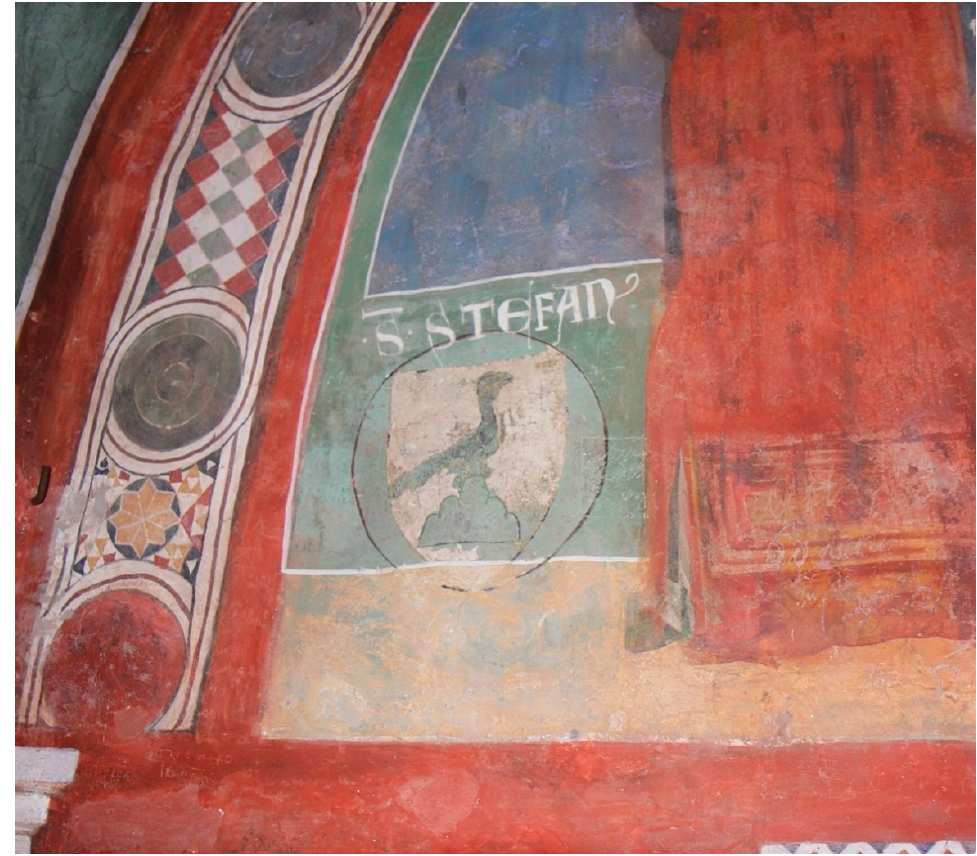
Figure 13. Sacro Speco, Subiaco (Italy), Lower Church. Fresco. Lunette, particular of the coat of arms. Photo: Davide Giannetti.